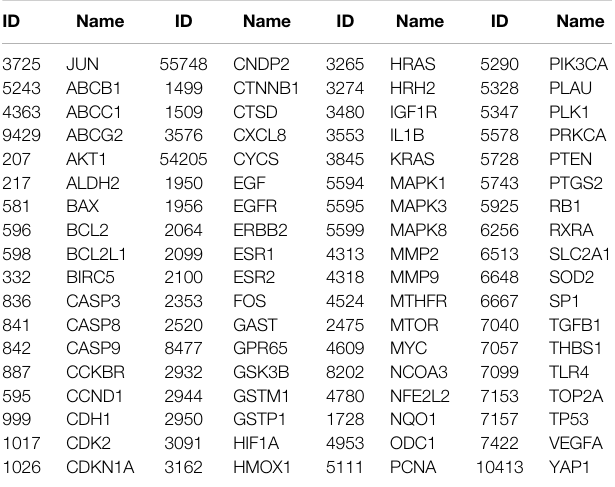
TABLE 1 | The target genes of Huangqi Jianzhong